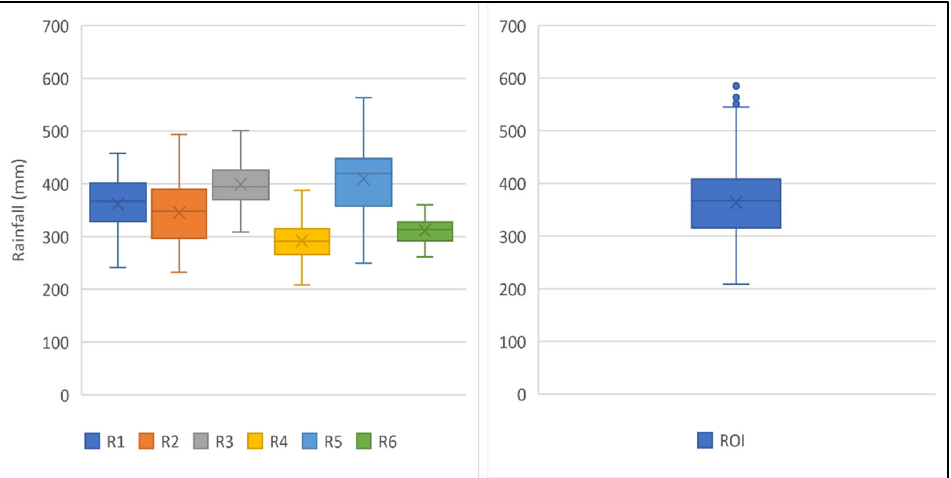
Figure 14. Extreme rainfall of six sub-regions within region of interest and the whole region of interest at 5 ‐ year.